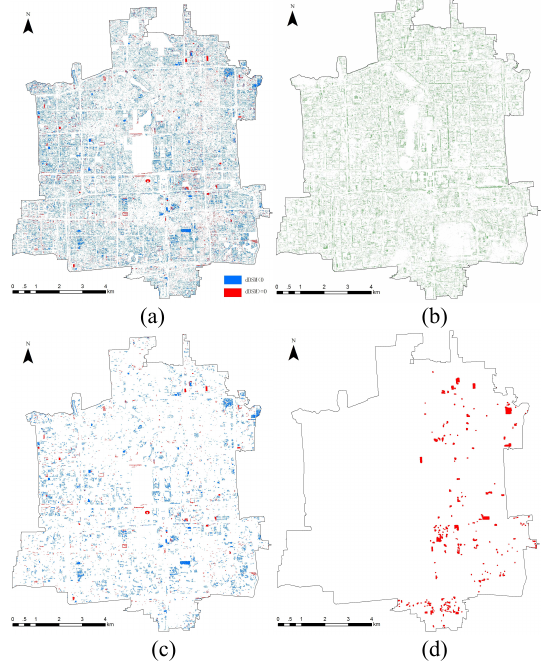
Figure 7. DSM difference and filter results. (a) DSM difference result between 2015 and 2017, (b) Tree masks from by segmentation and tree extraction with TDOM, (c) filtered result, (d) manually extracted changes of the Dongcheng District The number of patches decreased from 395780 to 3915 before and after filtering with masks and threshold calculation. For Dongcheng Distract, the number of patches extracted automatically and identified artificially were 1702 and 549, respectively. Compared with the visual interpretation result, the method could effectively identify changes in plane